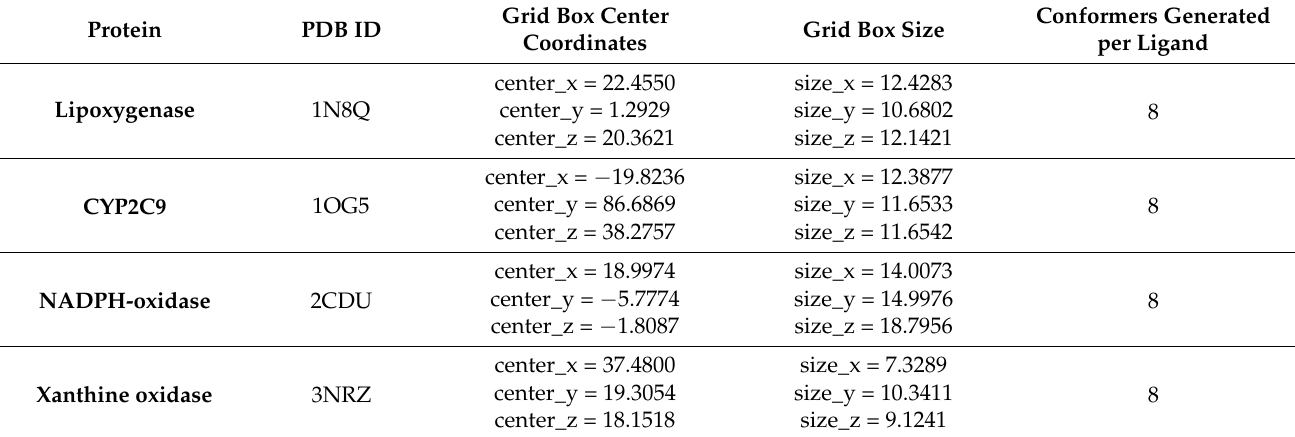
Table 1. Molecular docking parameters and protein